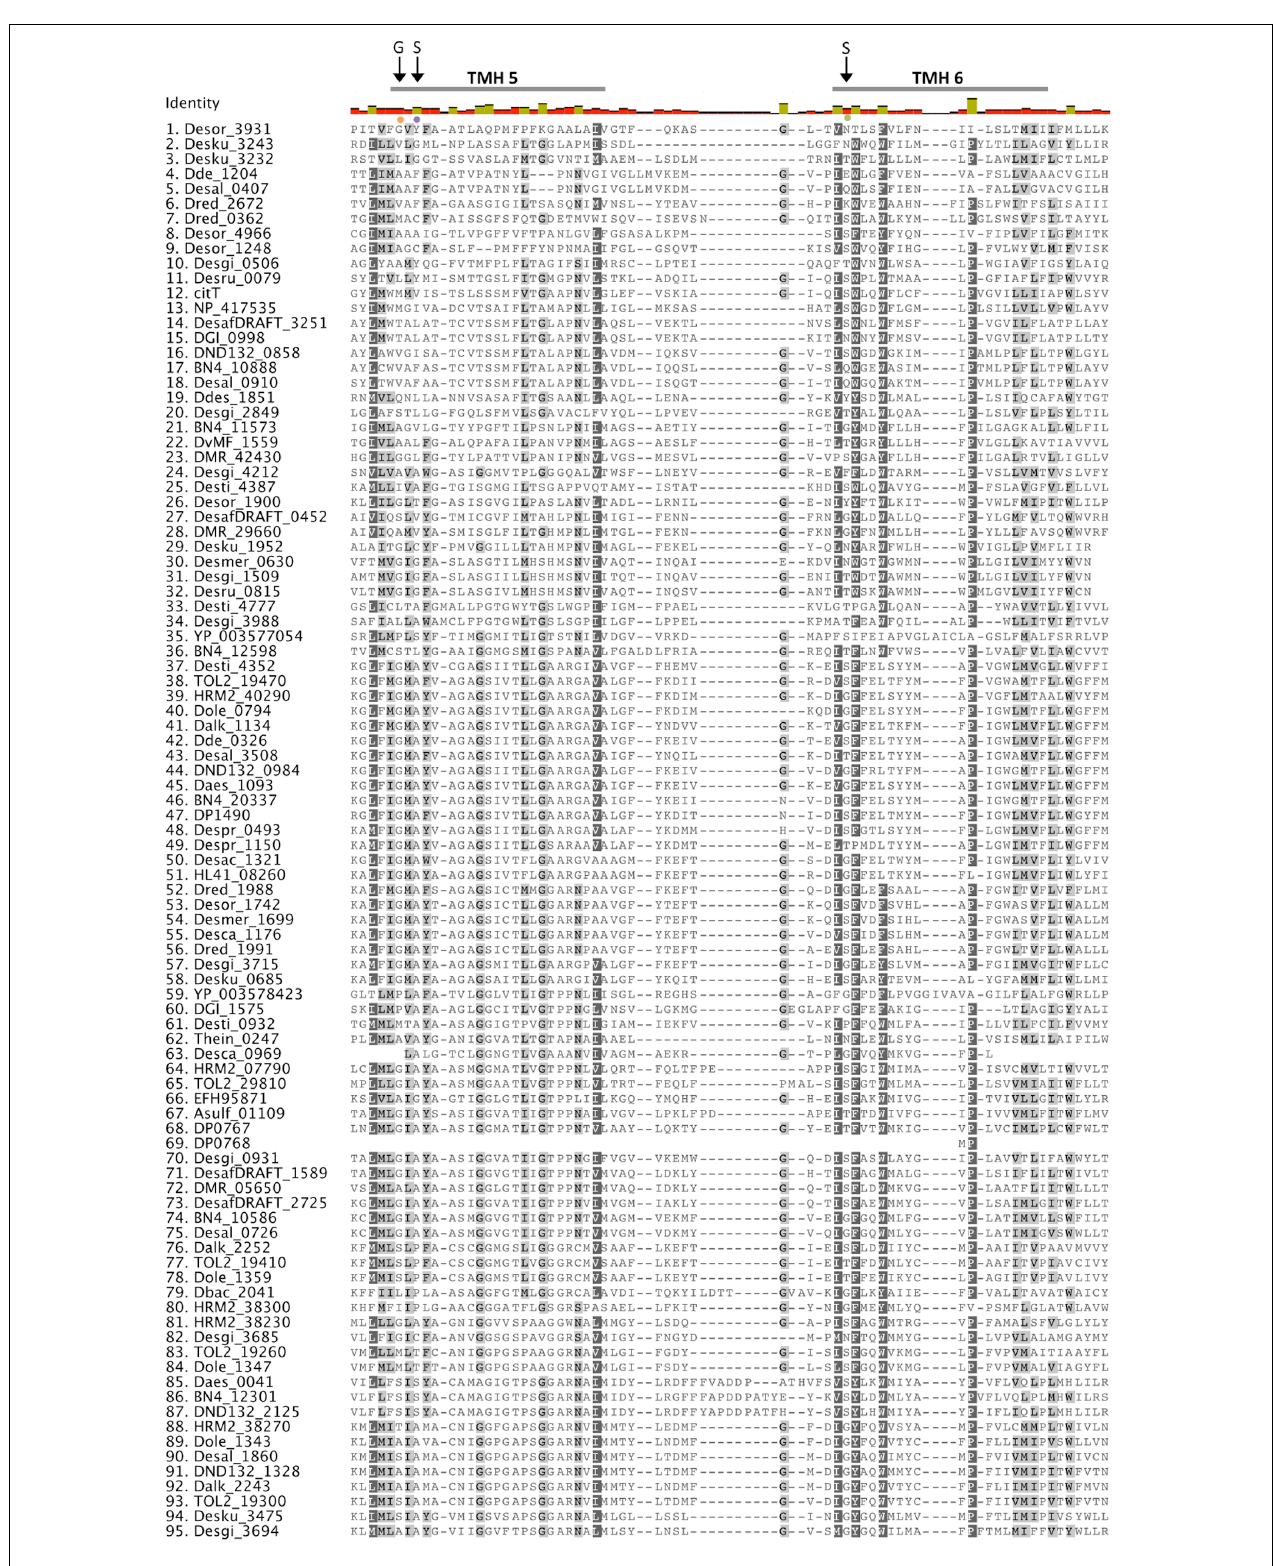
FIGURE 6 | Alignment of putative DASS sulfate transporters. The transporter sequences were selected on their phylogenetic relationship to the model DASS sequences. Invariant, conserved, and non-conserved residues are indicated by green, olive and red bar chart, respectively. Residues of interest are indicated by black